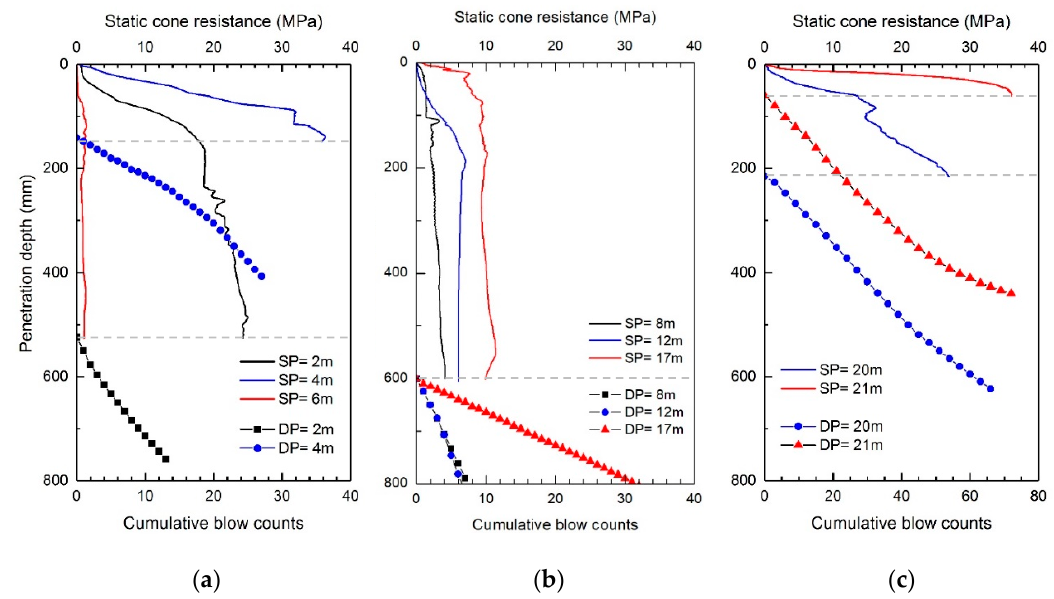
Figure 6. Profiles of static cone resistances and cumulative blow counts obtained from ICP in BH 1 at site A: ( a ) 2–6 m; ( b ) 8–17 m; ( c ) 20–21 m. SP and DP denote the static and dynamic cone penetration tests, respectively. Note that the data points of dynamic penetration at depths of 20 and 21 m indicate penetration depths at every three blows.